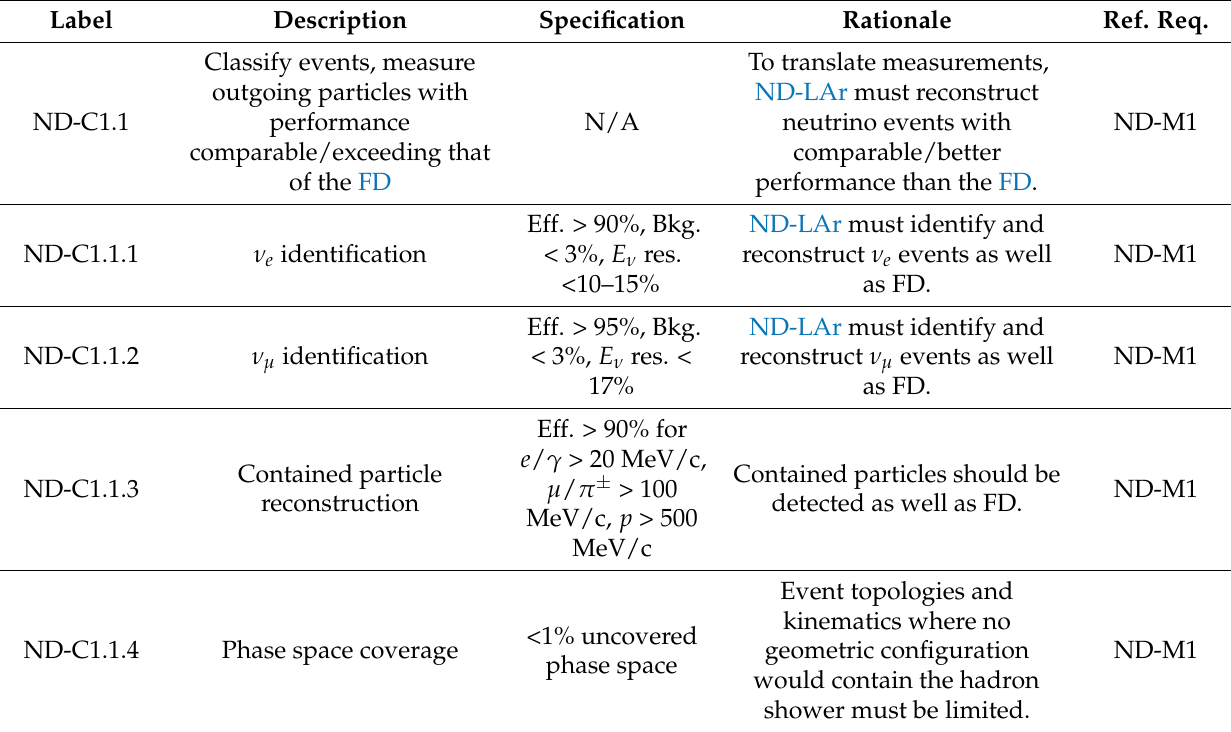
Table 4. ND-M1 capability requirements for ND-LAr with ND-GAr acting as a muon spectrometer.